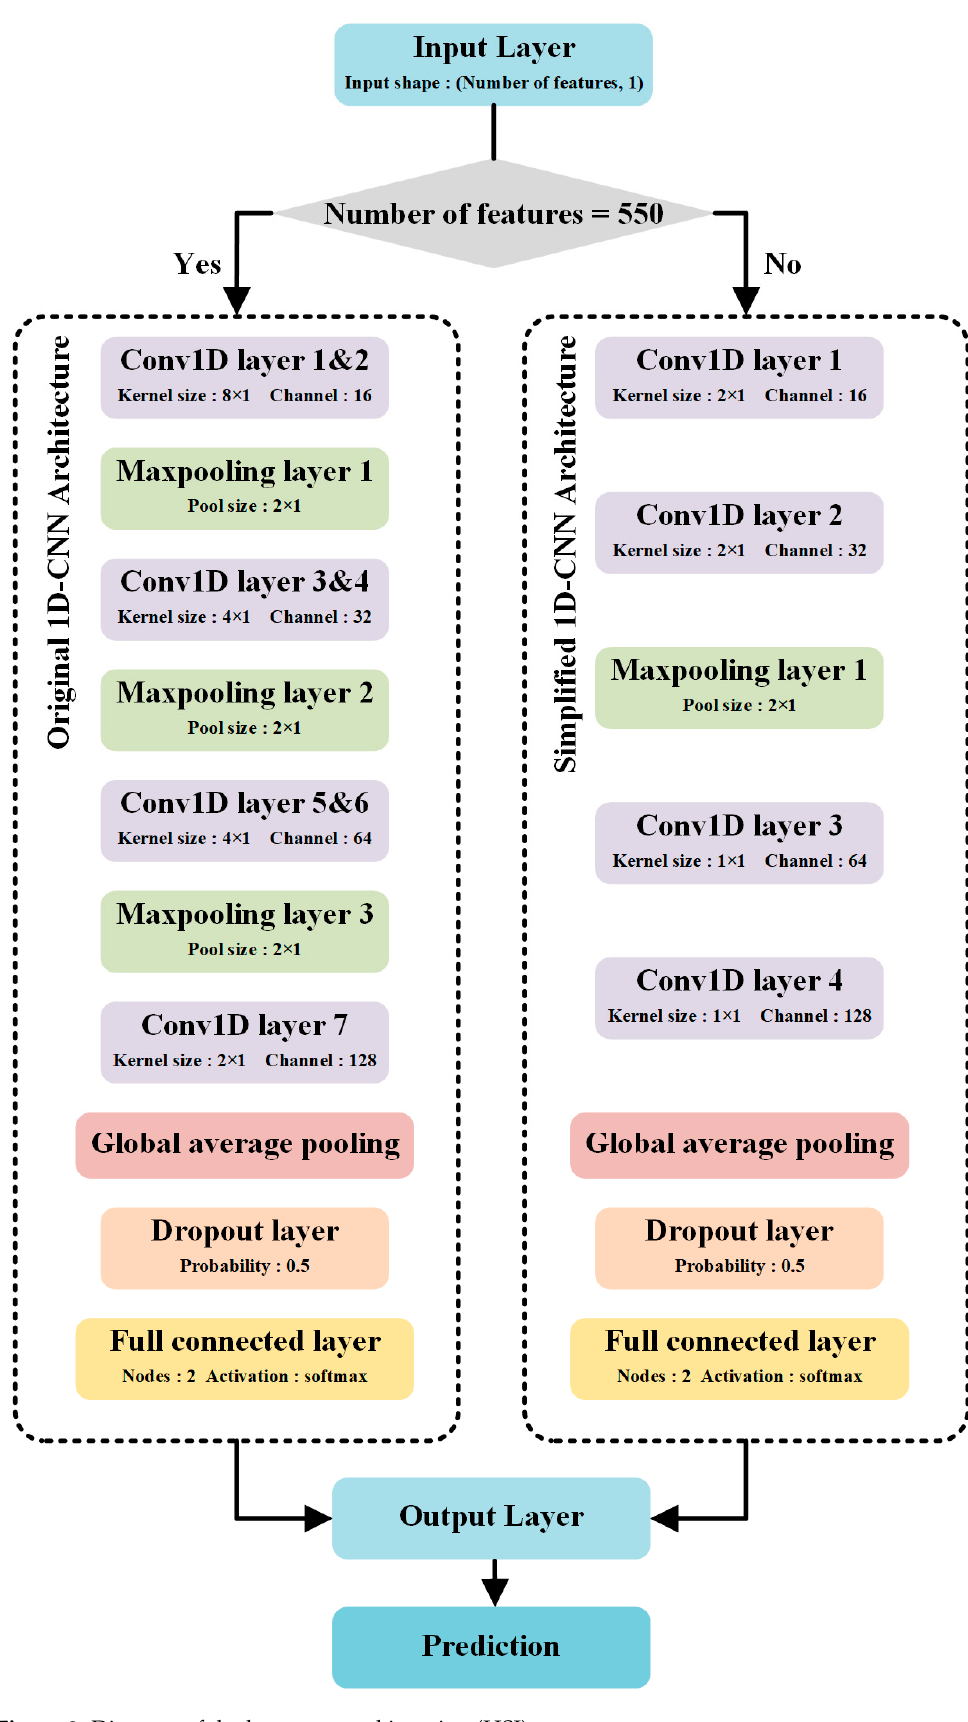
Figure 2. Diagram of the hyperspectral imaging (HSI) system.